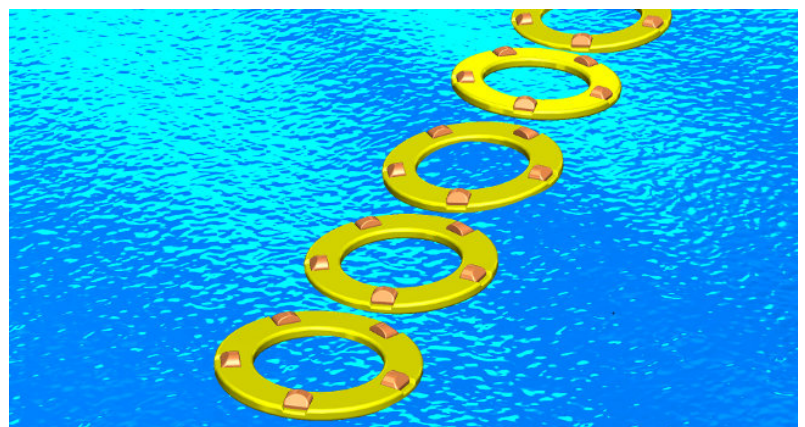
Figure 3. Artistic impression of a WEC energy array based on Lifesaver